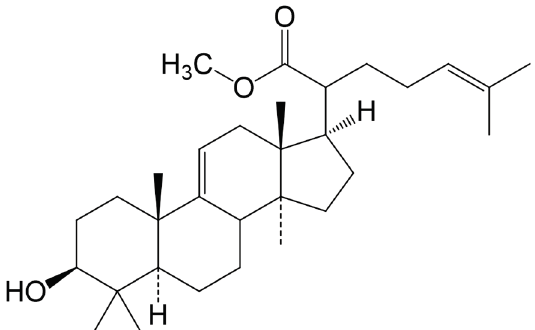
Figure 1. Methyl-3 β -hydroxylanosta-9,24-dien-21-oate ( RA-3 ).